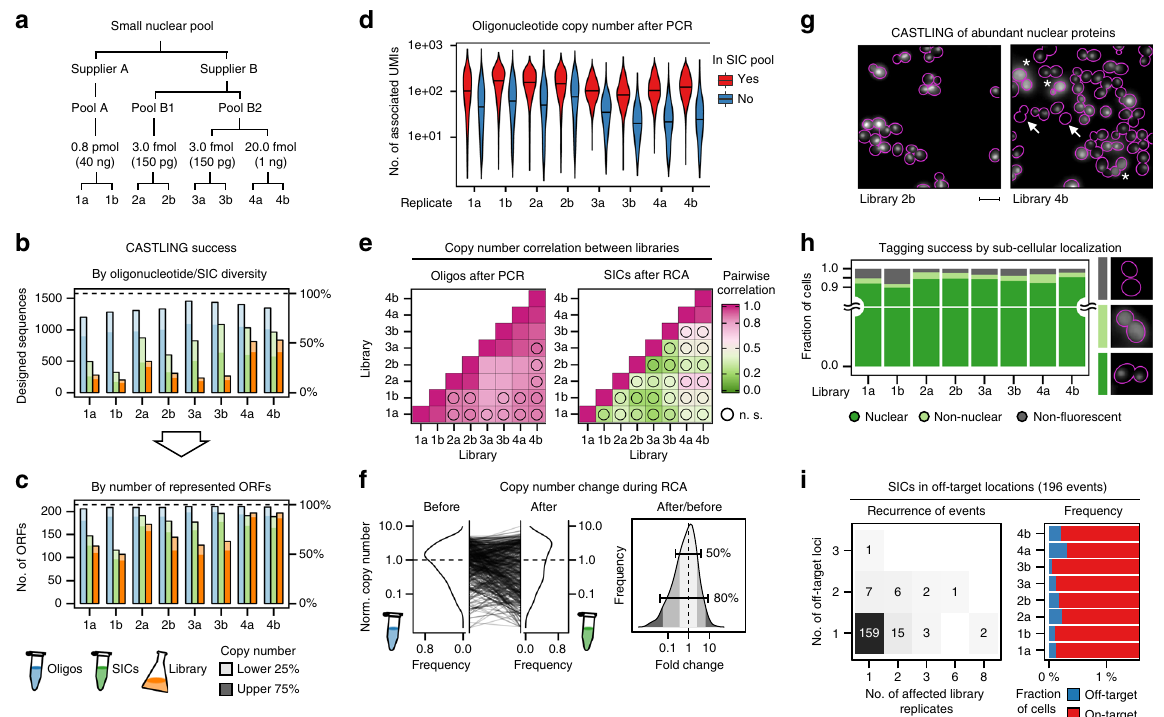
Fig. 3 CRISPR-Cas12a (Cpf1)-assisted tag library engineering (CASTLING) for tagging 215 nuclear proteins with a green fl uorescent protein. a Three oligonucleotide pools of the same design (1577 sequences, Supplementary Table 1) were used to create four tag libraries by CASTLING in duplicate sampling the indicated amount of starting material for PCR. b Detected oligonucleotide sequences of the design after PCR ampli fi cation (blue), self- integrating cassette (SIC) assembly (green), and in the fi nal library (orange); oligonucleotides with copy number estimates (unique molecular identi fi er (UMI) counts) in the lowest quartile (lower 25%) are shown in light shade. c Same as b , but evaluated in terms of open-reading frames (ORFs) represented by the oligonucleotides or SICs. d Copy number of PCR amplicons recovered (red) or lost (blue) after recombineering; black horizontal lines indicate median UMI counts. e Pearson ’ s pairwise correlation of oligonucleotide or SIC copy number between replicates after PCR or rolling circle ampli fi cation (RCA), respectively; n.s., not signi fi cant ( p > 0.05). f Kernel density estimates of copy number in replicate 1a as normalized to the median copy number observed in the oligonucleotide pool (before recombineering) and after recombineering into the SIC pool (left panel); the distribution of fold changes (right panel) highlights two frequency ranges: [0.1 – 0.9], that is, 80% of SICs, and [0.25 – 0.75], that is, 50% of SICs. g Representative fl uorescence microscopy images of cells displaying nuclear, diffuse non-nuclear (asterisks), or no mNeonGreen fl uorescence (arrows); scale bar 5 µ m. h Quanti fi cation of fl uorescence localization in >1000 cells in each replicate. i Recurrence of off-target events as revealed by Anchor-Seq across all library replicates and